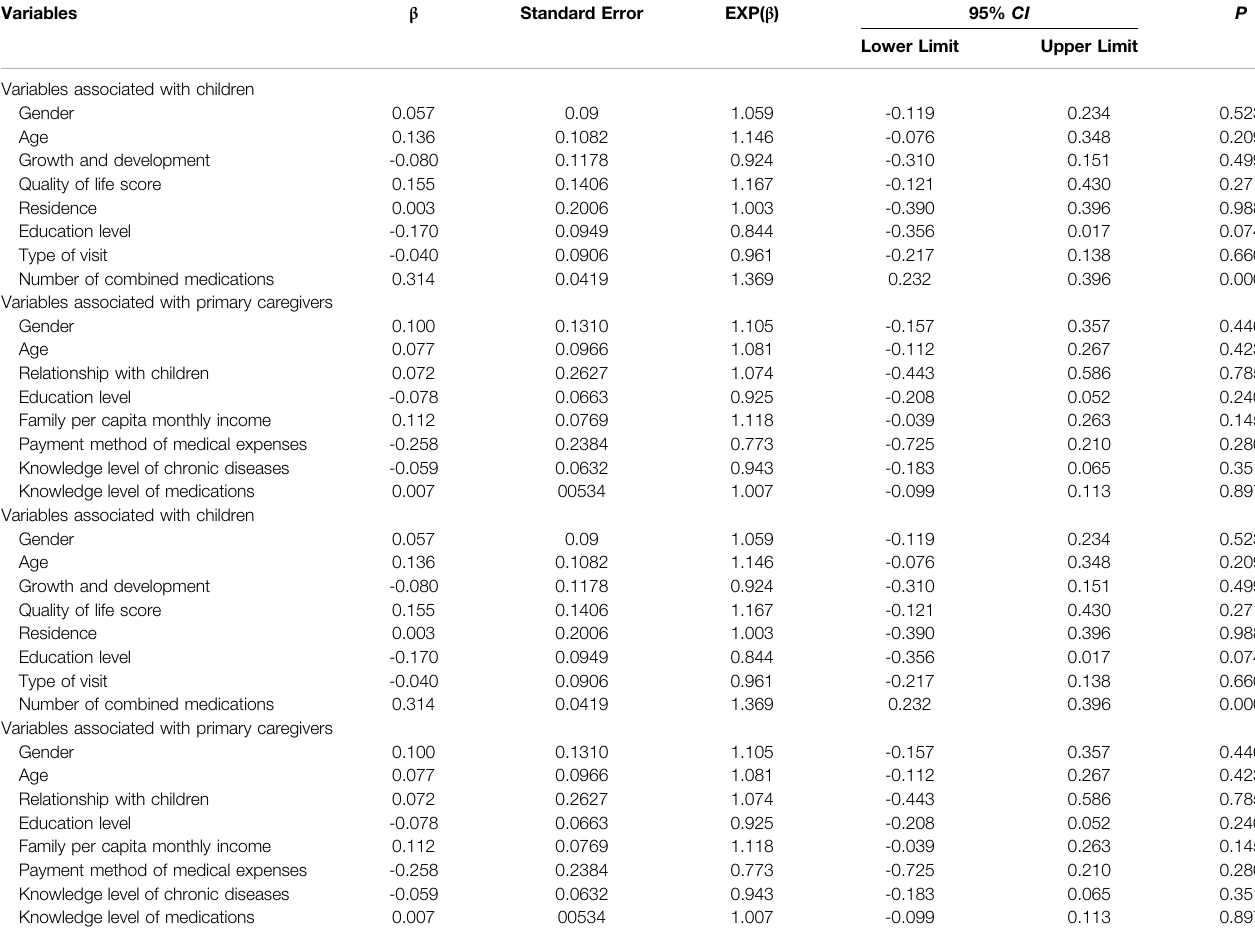
TABLE 4 | Poisson regression of potential factors associated with thefrequency of detected DRPs.